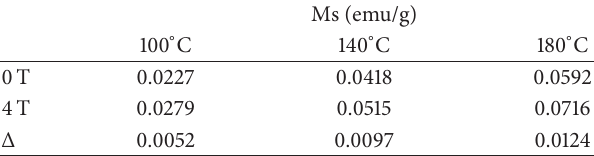
Table 2: The saturation magnetizations of the